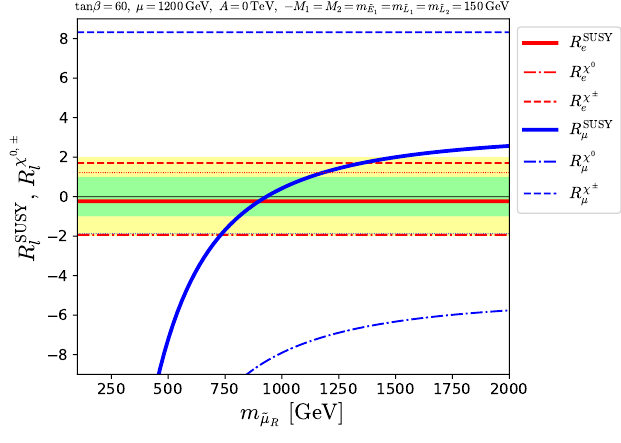
Figure 1 . R SUSY (solid), R (cid:31) (cid:6) (dashed) and R (cid:31) 0 (dashed-dotted) for electron (red) and muon l l l (blue) as a function of m ~ (cid:22) . Very thin dotted lines around 1 (red for electron) and (cid:0) 2 (blue for R muon) correspond to (cid:0) (cid:1) a l = (2 (cid:27) l ), which R (cid:31) (cid:6) and R (cid:31) 0 approach in the decoupling limit. l l